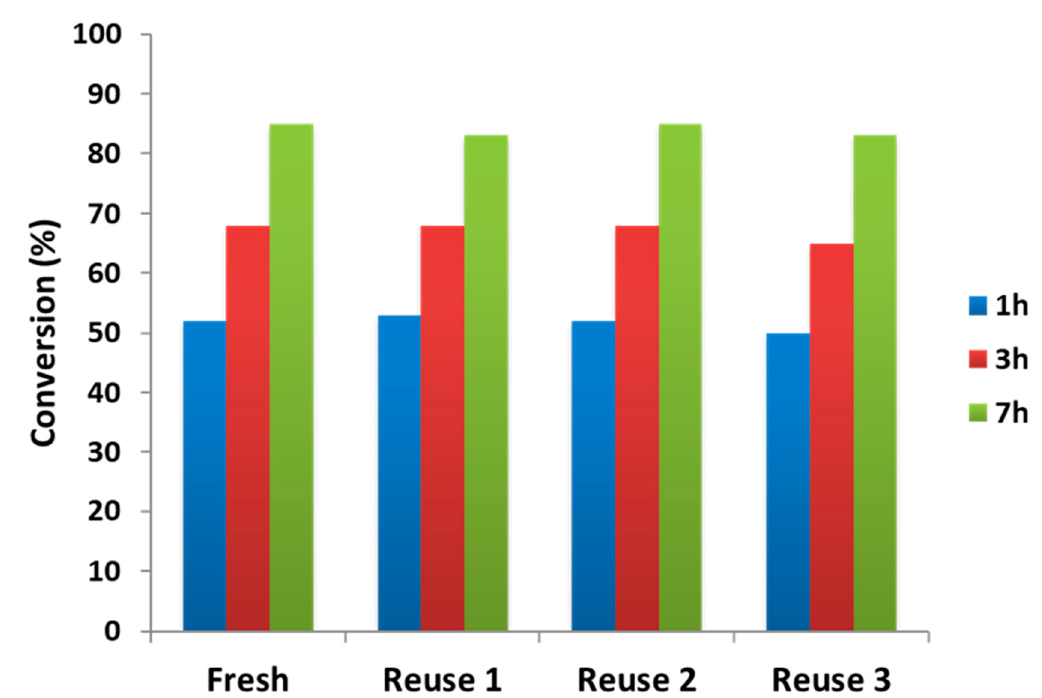
Figure 8. Reusability tests for Pd/TiO 2 nano catalyst in the mild hydrotreatment of tars. Reaction conditions: 0.5 g of tars-type compounds, 4 g of n-hexadecane, 0.2 g of catalyst, at 275 °C and 30 bar of H 2 .